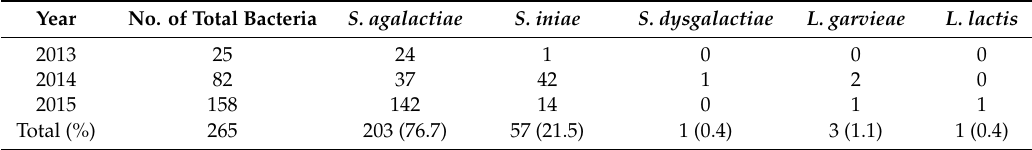
Table 1. Identification of Gram-positive cocci isolated from Tilapia from 2013 to 2015.